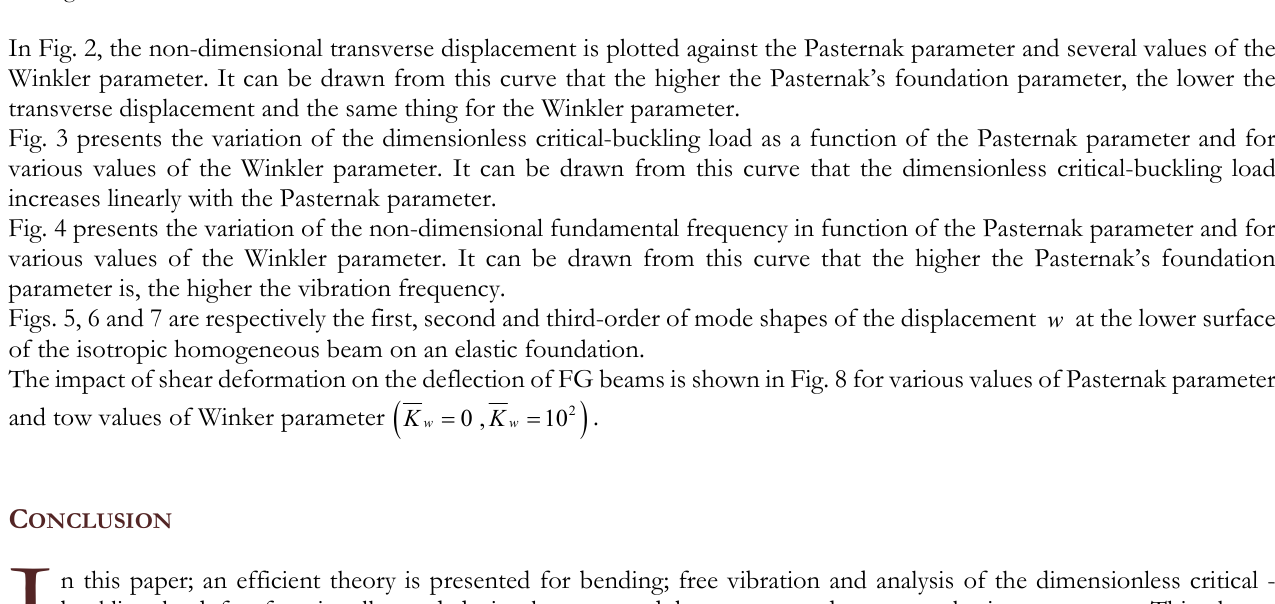
Figure 8: Effect of shear deformation, Pasternak parameter p K , and Winkler parameter w K on the deflection of isotropic homogeneous beams under uniform